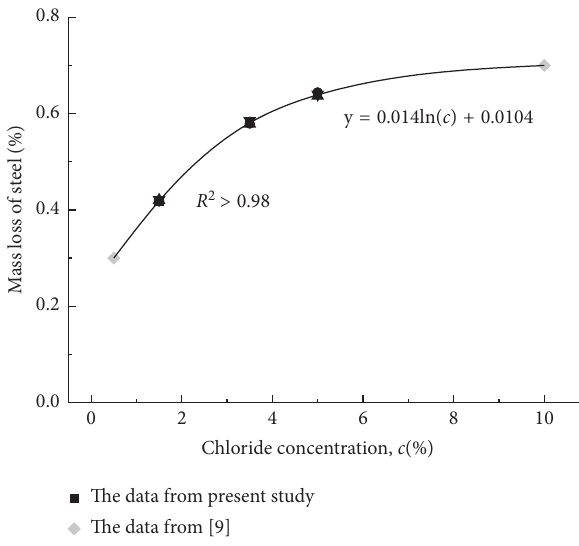
Figure 4: Mass loss at the corrosion initiation